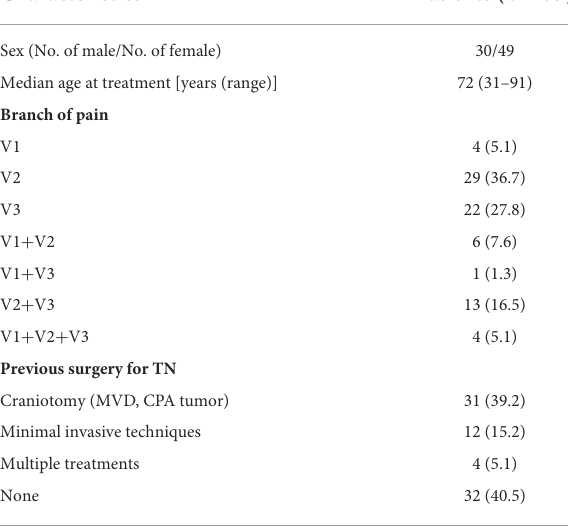
TABLE 1 Characteristics of 79 patients undergoing PBCs. Characteristics